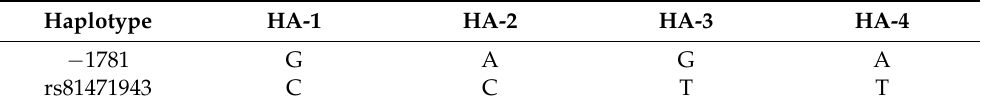
Table 4. Relationship between Duroc pigs of different EXOC4 genotype with the SNP promoter.